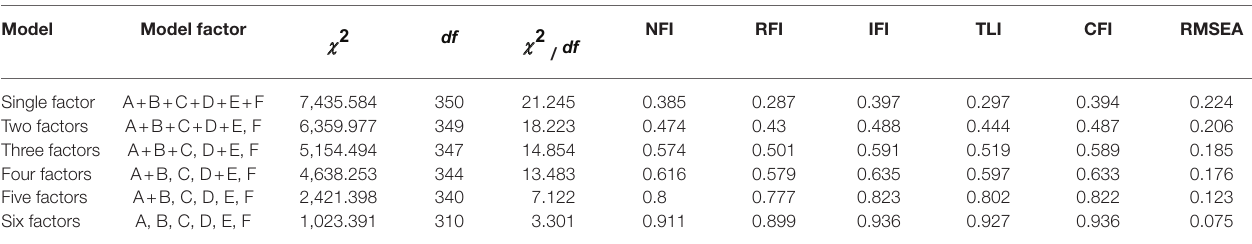
TABLE 2 | Confirmatory factor analysis.